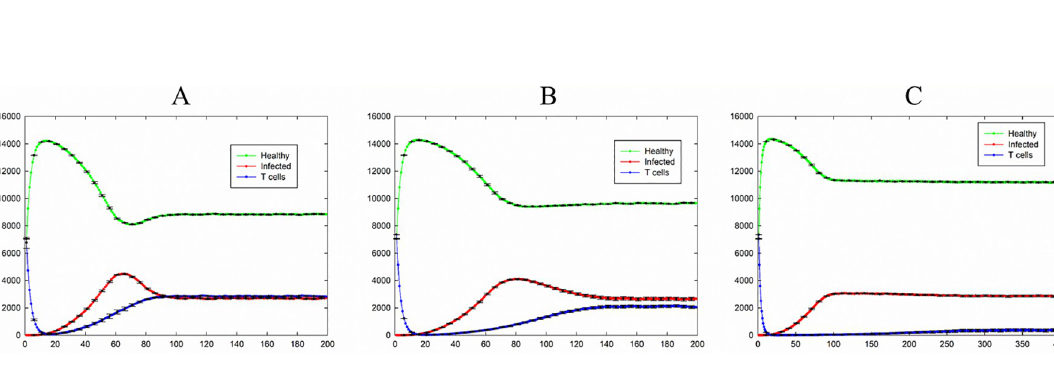
Fig 6. Total number of healthy, infected, and T cells versus time for the case of P I = 0.4, P T = 0.6, and P D = 0.3; A) P H = 0.3. B) P H = 0.6. C) P H = 0.9. Healthy, infected, and T cells are shown in green, red, and blue, respectively. The standard errors are shown by error